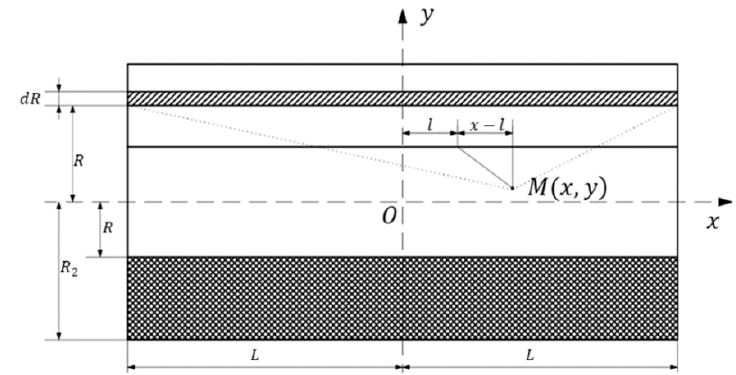
Figure 6. Schematic diagram of acceleration coil.